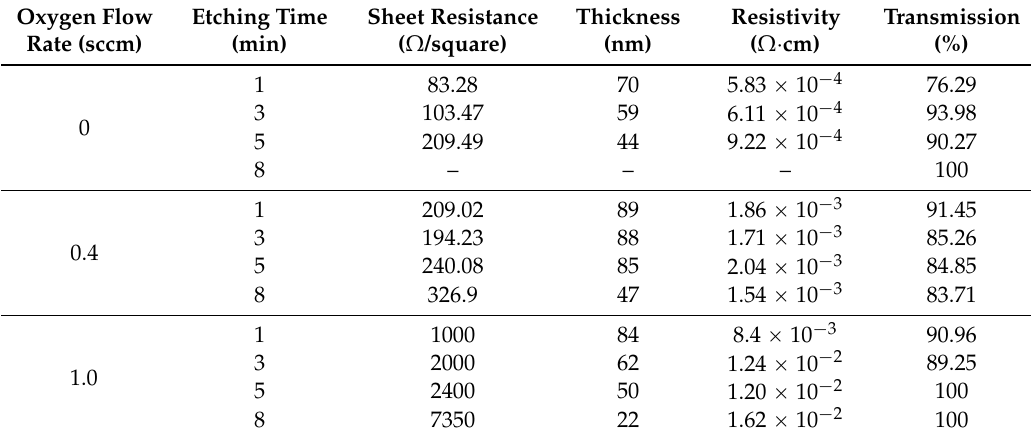
Table 2. Electrical and optical parameters of ITO films deposited under various oxygen compositions and etched for 1, 3, 5 and 8